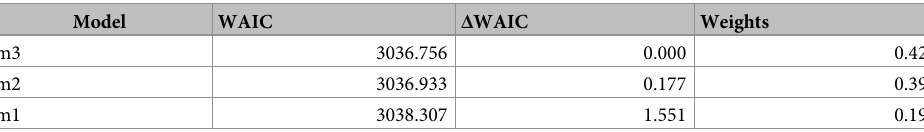
Table 3. Summary of WAIC based model